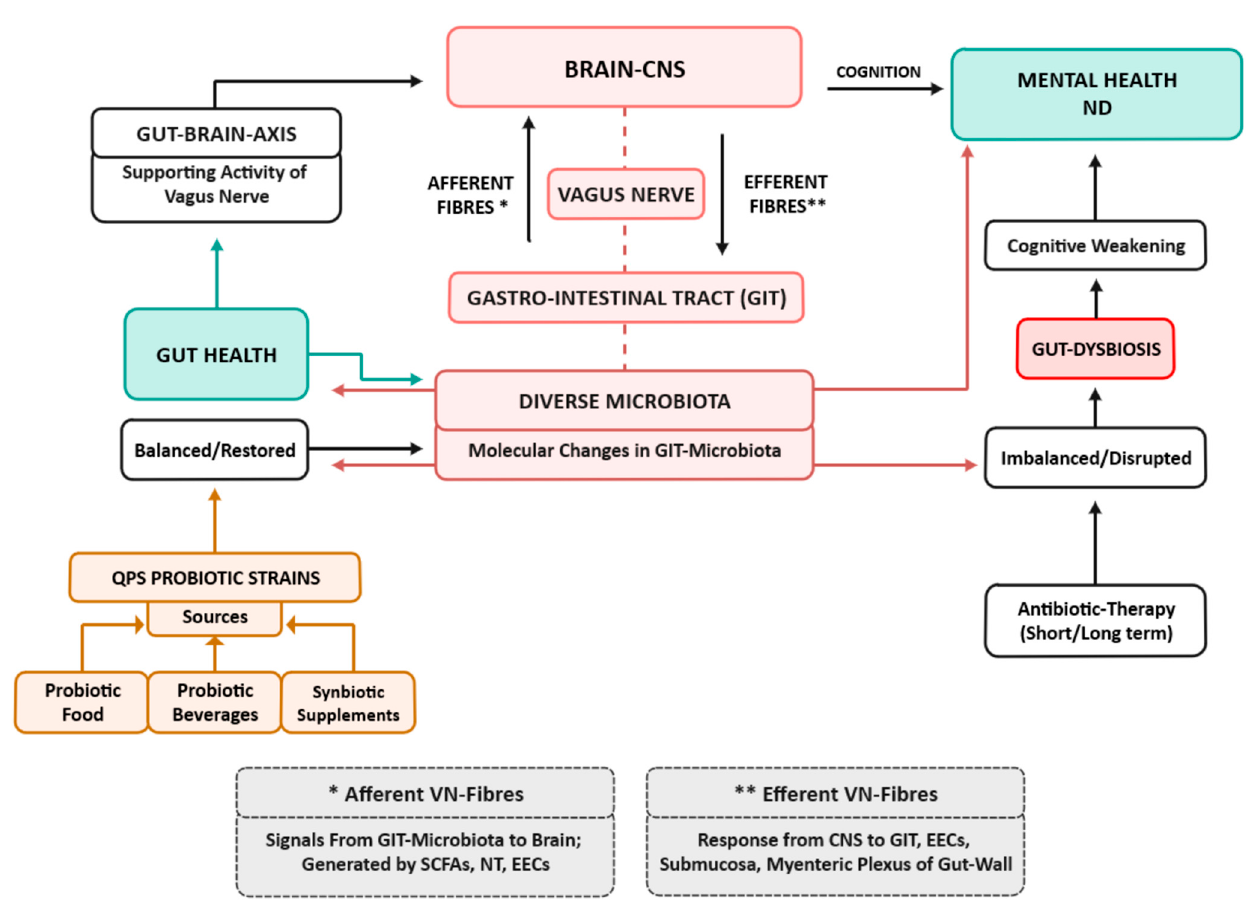
Figure 1. Antibiotic-therapy-induced gut dysbiosis affecting gut-microbiota–brain axis and cognition, and its restoration by probiotics [2,21,86,89,90] QPS—Qualified presumption of safety; CNS—Central nervous system; ND—Neuropsychiatric disorders; NT—Neurotransmitters; SCFA—Short-chain fatty acids; EEC—Entero-epithelial cells.